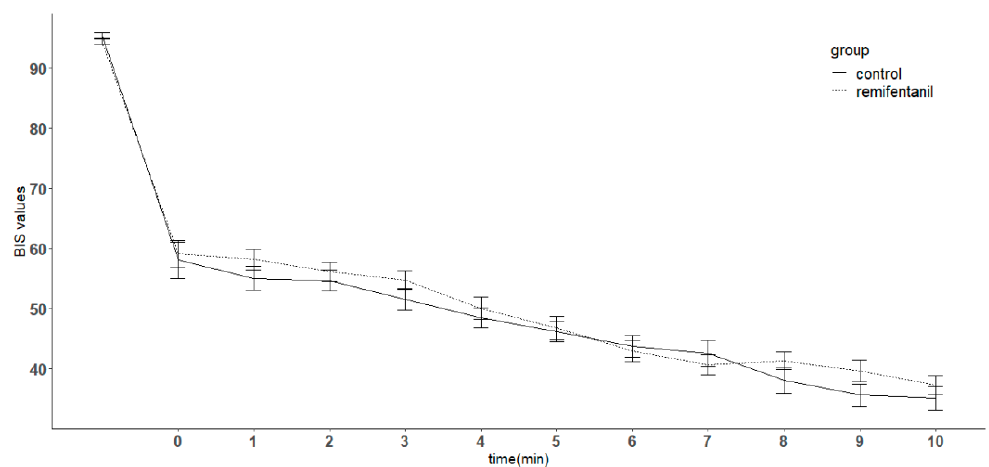
Figure 2. Changes in the bispectral index (BIS) in patients with or without remifentanil infusion. In unconscious patients with propofol at the target e ff ect-site concentration of 5 µ g / mL, a remifentanil target e ff ect-site concentration of 5 ng / mL was infused in the remifentanil group throughout the study period. The control group received normal saline instead of remifentanil. BIS decreased over time for both the control and remifentanil group compared to the preoperative value ( p < 0.05), but there was no di ff erence between the two. Error bar indicates standard error. In the x axis, time point 0 indicates the time the remifentanil infusion was started at an e ff ect-site concentration of 5 ng / mL. Seven patients in the remifentanil group required ephedrine to maintain their blood pressure, compared with zero patients in the control group. Mean arterial blood pressure decreased over time ( p < 0.05), but there was no di ff erence between the groups at any time point (Figure 4). Heart rate decreased over time, but no significant di ff erence was observed between them. However, at 7, 8, 9, and 10 min, the remifentanil group had a decreased heart rate compared with the control group ( p < 0.05) (Figure